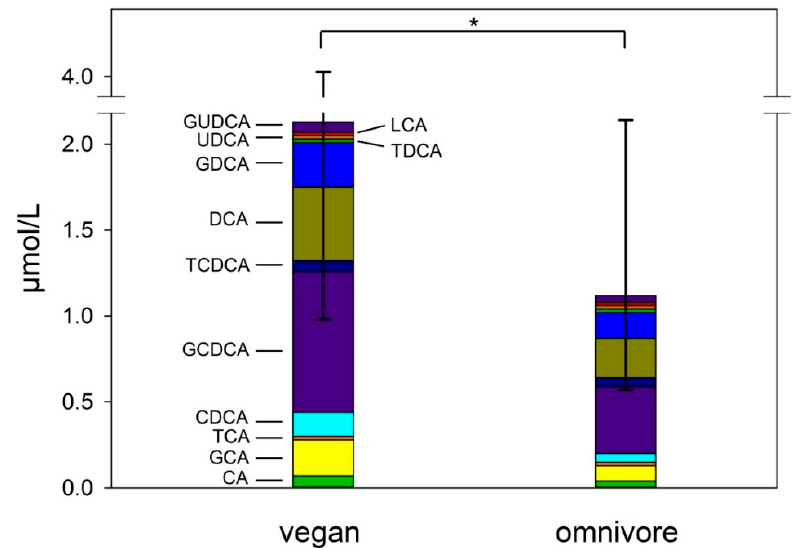
Figure 2. Serum bile acids concentrations in vegans and omnivores of the RBVD study (µmol/L). Data are presented as medians and IQR for total serum bile acids. Mann–Whitney U test was used for bile acids (* p ≤ 0.001). CA = Cholic acid, GCA = glycine-conjugated CA, TCA = taurine-conjugated CA, CDCA = Chenodeoxycholic acid, GCDCA= glycine-conjugated CDCA, TCDCA = taurine-conjugated CDCA, DCA = Deoxycholic acid, GDCA = glycine-conjugated DCA, TDCA = taurine-conjugated DCA, UDCA = Ursodeoxycholic acid, GUDCA = glycine-conjugated UDCA, LCA = Lithocholic acid.